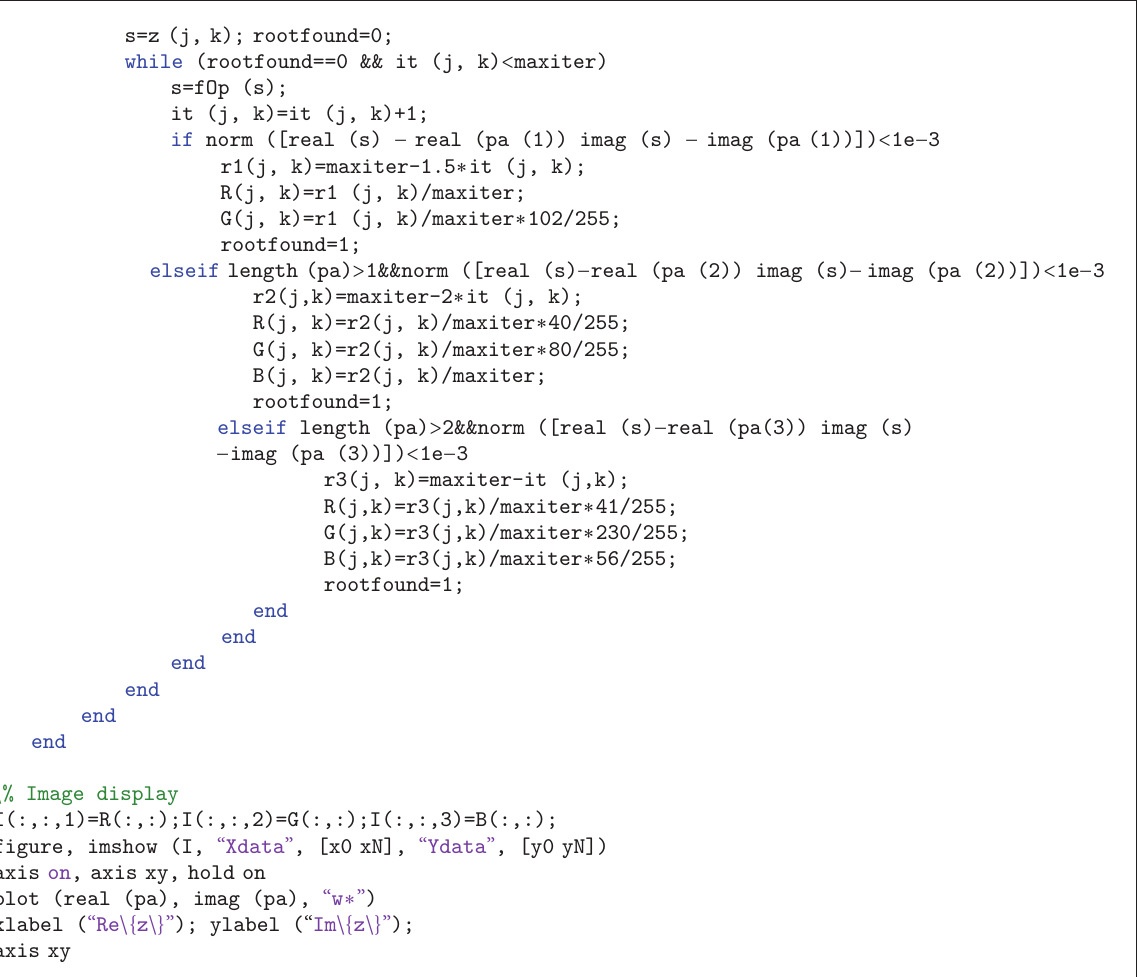
(91) figure, imshow (I, “ Xdata ” , [x0 xN], “ Ydata ” , [y0 yN]) (92) axis on, axis xy, hold on (93) plot (real (pa), imag (pa), “ w ∗ ” ) (94) xlabel ( “ Re \{ z \} ” ); ylabel ( “ Im \{ z \} ” ); (95) axis xy